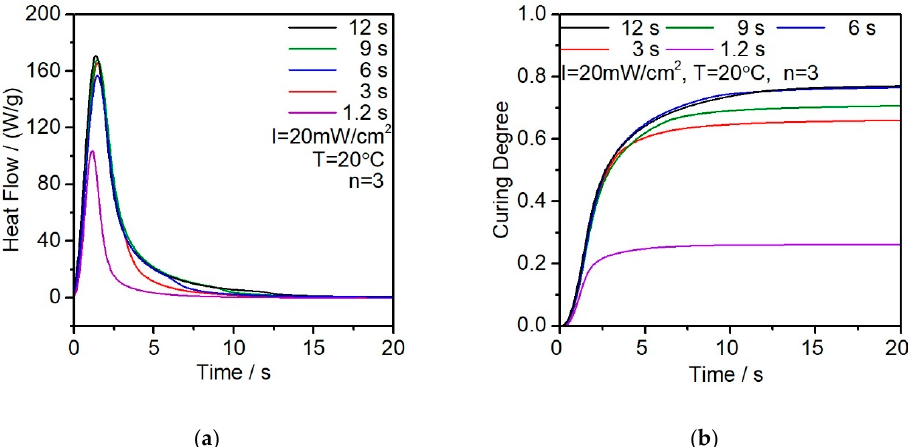
Figure 6. ( a ) Enthalpy analysis with different exposure times; ( b ) calculated curing degree in function with the exposure time. Table 2. Thermal properties analysis results for di ff erent exposure times.